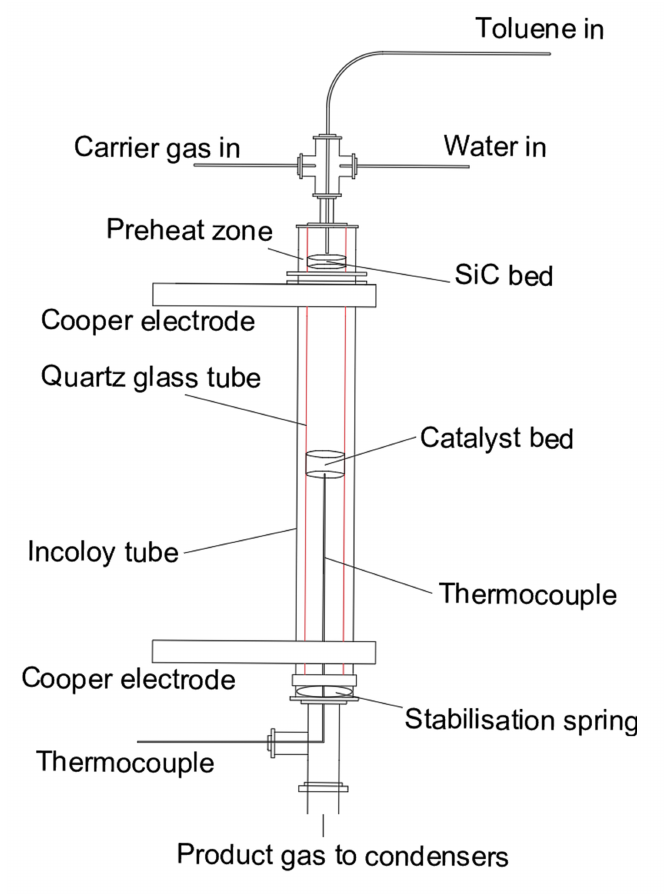
Figure 2. Reactor diagram of catalytic toluene steam